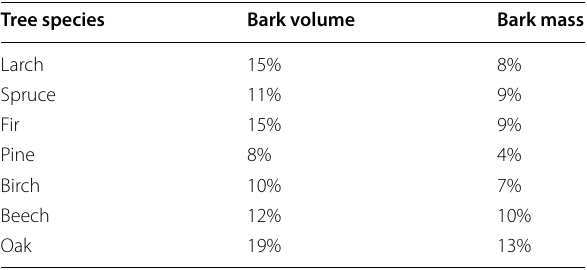
Table 10 Volume and mass proportions (%) of bark in coarse